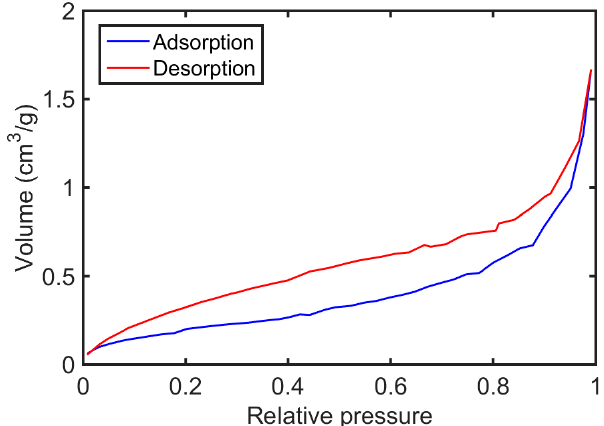
Figure 10. Typical nitrogen adsorption and desorption isotherm of insulating paper.